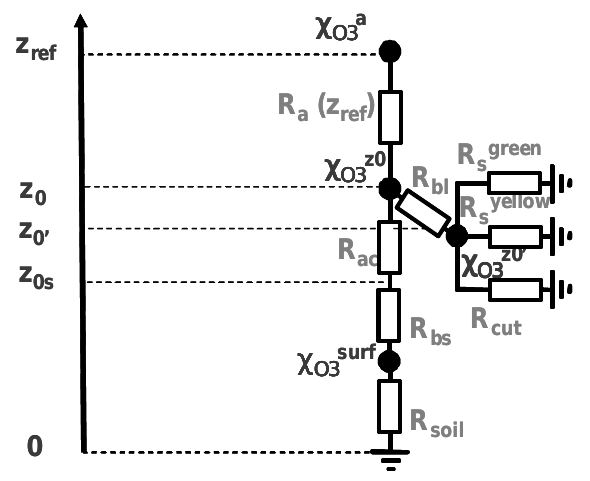
Fig. 1. Resistive scheme for O 3 exchange model. z is the height above ground; R a , R ac , R bl , R bs , R soil , R cut , R sgreen , and R syellow are aerodynamic resistance, in-canopy aerodynamic resistance, leaf quasi-laminar boundary layer resistance, soil quasi-laminar boundary layer resistance, soil resistance, cuticular resistance, green leaf stomatal resistance, and yellow leaf stomatal resistance respectively; χ O3 is the ozone concentration; indexes ref , a , z 0 , z 0’ , and z 0s refer to reference, atmospheric, canopy roughness height for momentum, canopy roughness height for scalar, and soil roughness height respectively.